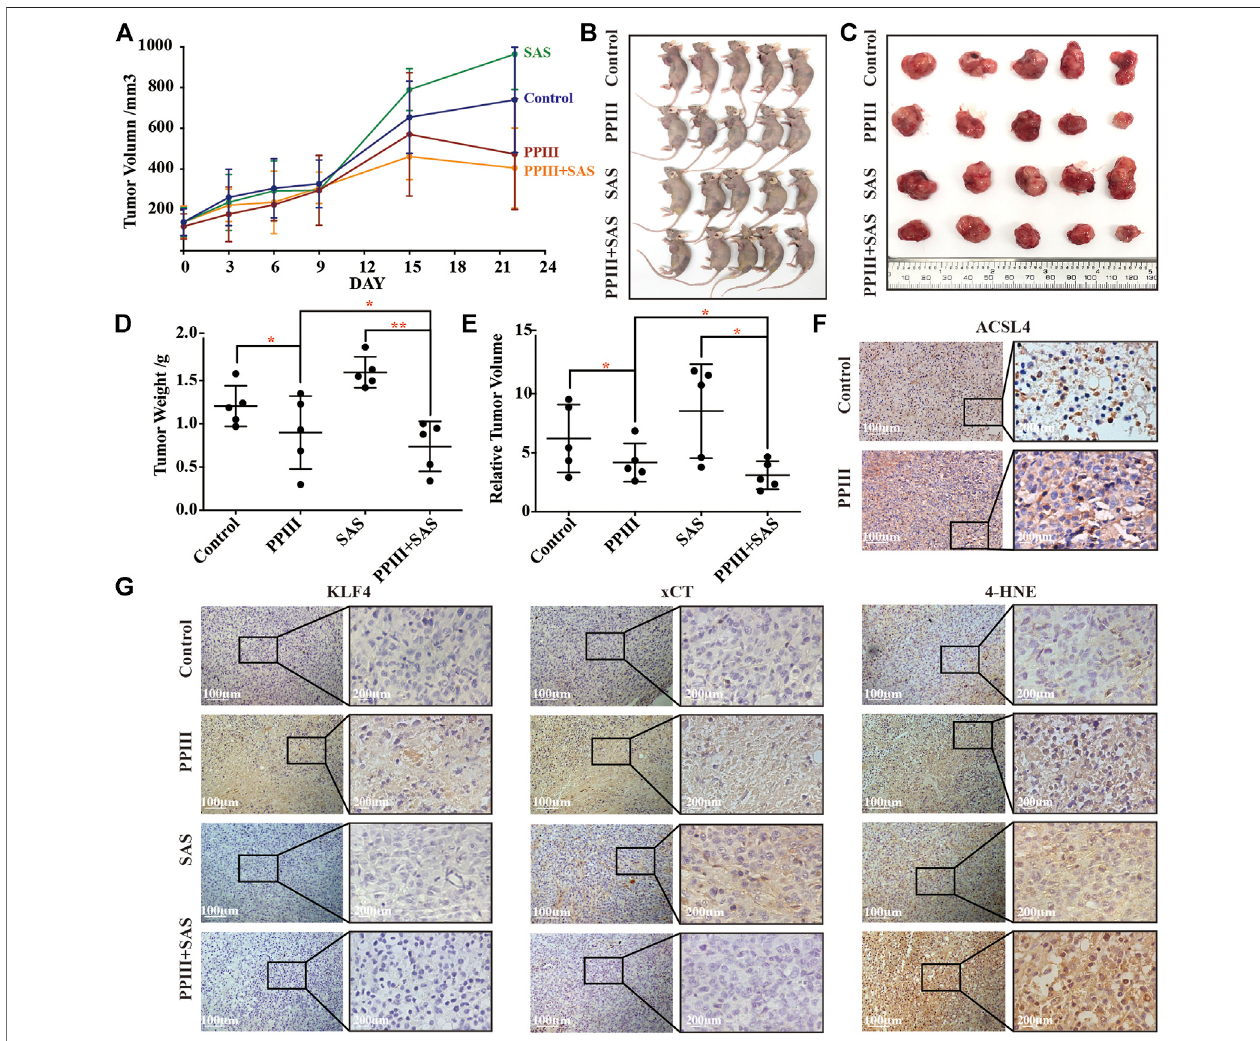
FIGURE 6 | Polyphyllin III treatment with or without SAS suppressed tumor growth in vivo . (A) . Athymic nude mice were orthotopically injected with MDA-MB-231 cells and treated with Polyphyllin III and/or SAS daily by intraperitoneal injection until the end of experiments. The tumor volumes of MDA-MB-231 xenograft tumors at differenttimepoints(days)duringtheindicatedtreatmentsareshown.Theerrorbarsshowthemeans ± SD, n (cid:2) 5independentrepeats. p valueswerecalculatedusinga two-tailed paired Student ’ s t-test. (B) . Images of the nude mice from each treatment group are shown at day 22 after the indicated treatment. (C) . Isolated tumor imagesfromeachtreatmentgroupareshownatday22aftertheindicatedtreatment. (D) .IndividualvalueplotshowingtheweightsofMDA-MB-231tumor xenograftsin each indicated treatment group at day 22. (E) . Individual value plot showing the relative tumor volumes of MDA-MB-231 tumor xenografts in each indicated treatment group at day 22. (F) . Immunohistochemical staining of ACSL4 in MDA-MB-231 xenograft tumors with or without Polyphyllin III treatment. (G) . Immunohistochemical staining of KLF4, xCT and 4-HNE in MDA-MB-231 xenograft tumors with the indicated treatments. Representative images of each group are shown. * p < 0.05; ** p < 0.01; *** p < 0.001; n. s., not signi fi cant ( p >